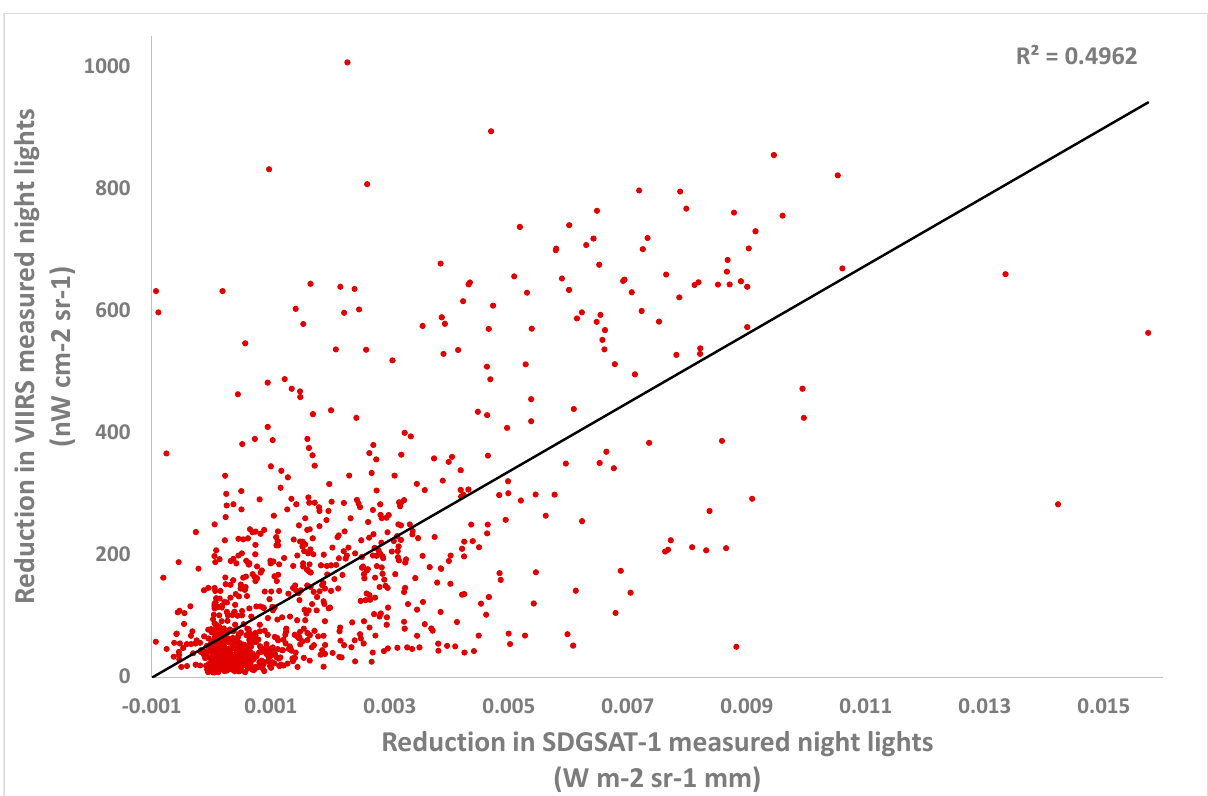
Figure 7. The correlation between lit VIIRS grid cells with statistically significant changes in VIIRS NTL ( p < 0.01) (comparing the 36 days before the 6 February earthquakes, and the 14 days after the 6 February earthquakes), and changes in SDGSAT-1 NTL values between 22 August 2022 and 12 February 2023. The lit grid cells analyzed here are those presented in Figure 4, for city of Antakya, Turkey (n = 1228).